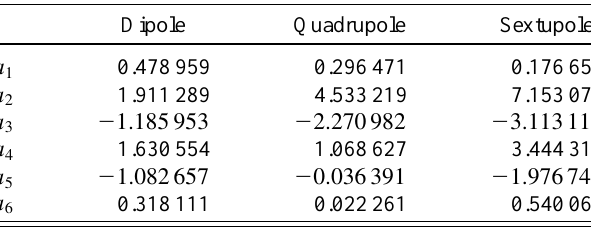
TABLE I. Enge coefficients of the default fringe field falloff used in COSY INFINITY for dipoles, quadrupoles, and sextupoles, respectively. Dipole Quadrupole Sextupole